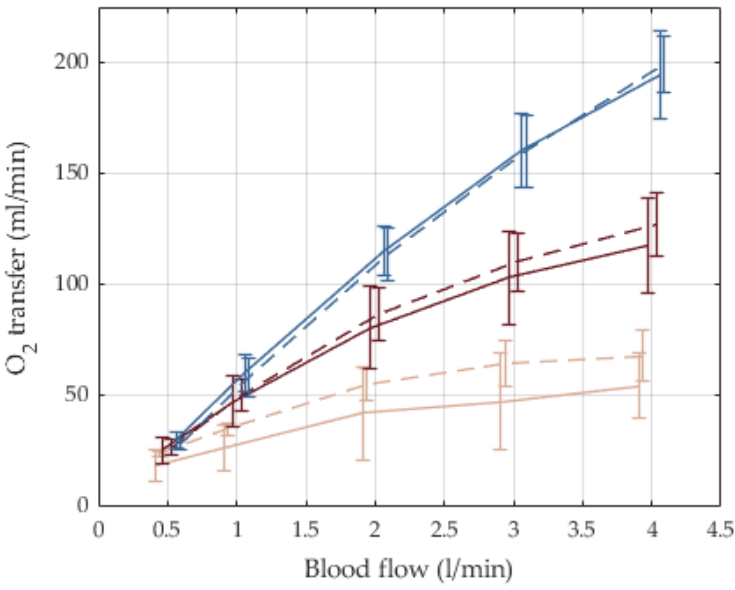
Figure 11. Oxygen transfer rates for different feed gas blends and gas/blood-flow ratios, n = 5, mean and SD. Beige: feed gas with pure ambient air, F i O 2 = 21%; red: feed gas blend with F i O 2 = 50%; blue: feed gas with medical oxygen, F i O 2 = 100%. Solid line: 1:1 flow ratio gas/blood; dashed line: 4:1 flow ratio gas/blood.